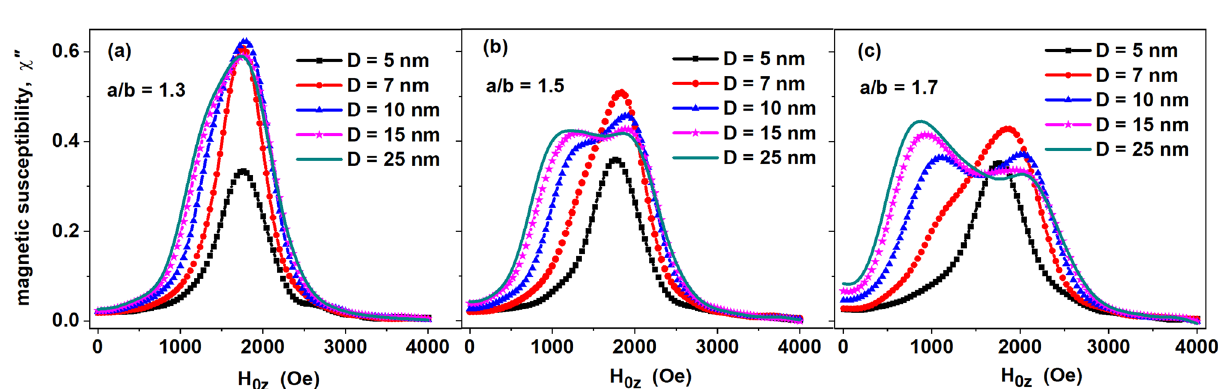
Figure 2. Dependence of the FMR spectrum of a dilute randomly oriented assembly of magnetite nanoparticles on the transverse particle diameter D = 2 b for various aspect ratios: ( a ) a / b = 1.3; ( b ) a / b = 1.5; ( c ) a / b = 1.7. FMR excitation frequency f = 4.9 GHz, magnetic damping constant κ = 0.1, T = 300